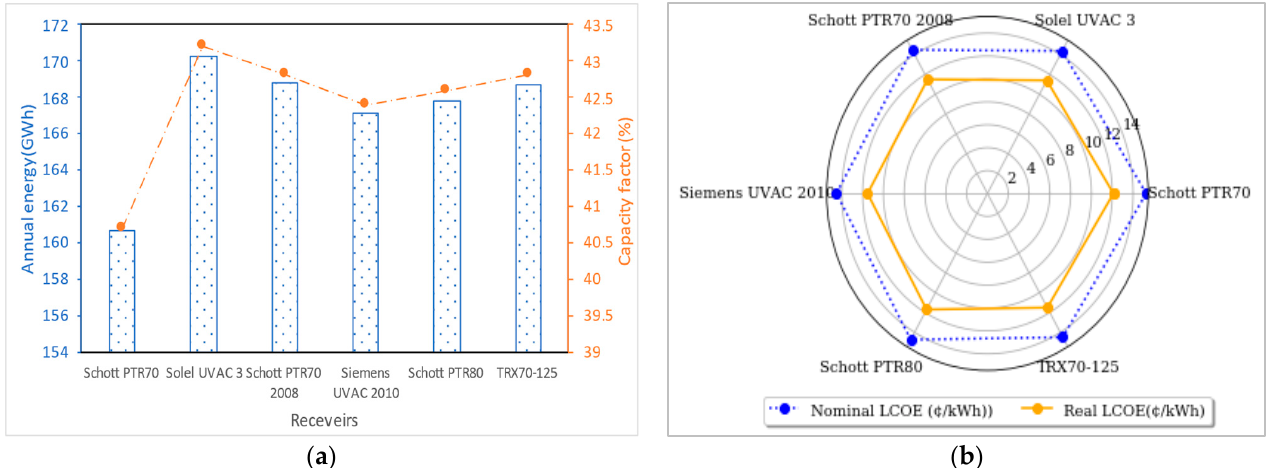
Figure 5 . Comparison of ( a ) output power and capacity factor and ( b ) nominal and real LCOE for PTC plant with different types of receivers .